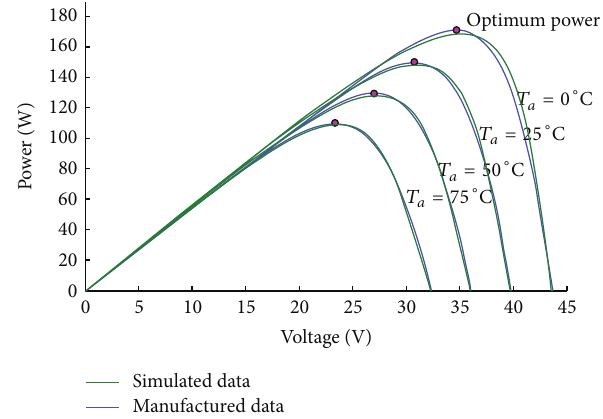
Figure 8: P-V characteristic curve at constant solar radiation of 1000 W/m 2 .